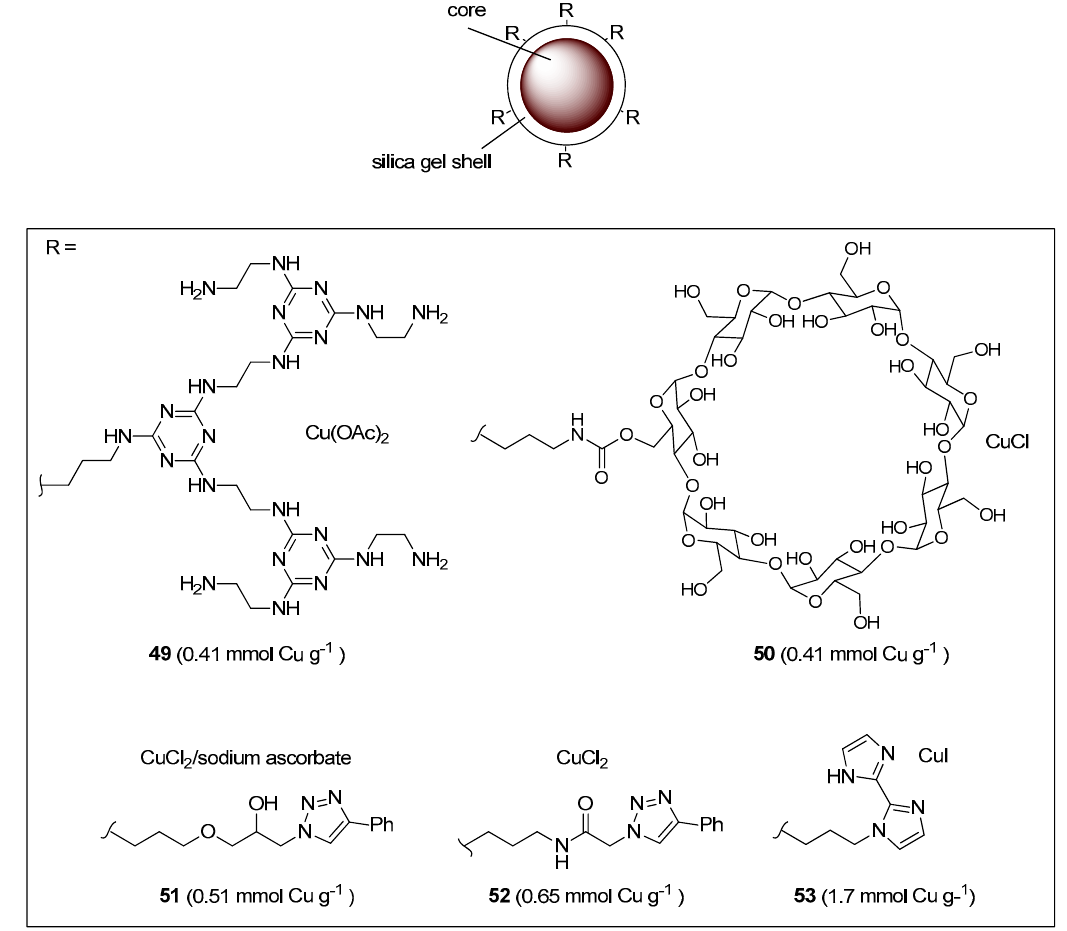
Figure 5. Cu(I/II) complexes 49 – 53 , containing organic ligands immobilized on magnetically recoverable supports.